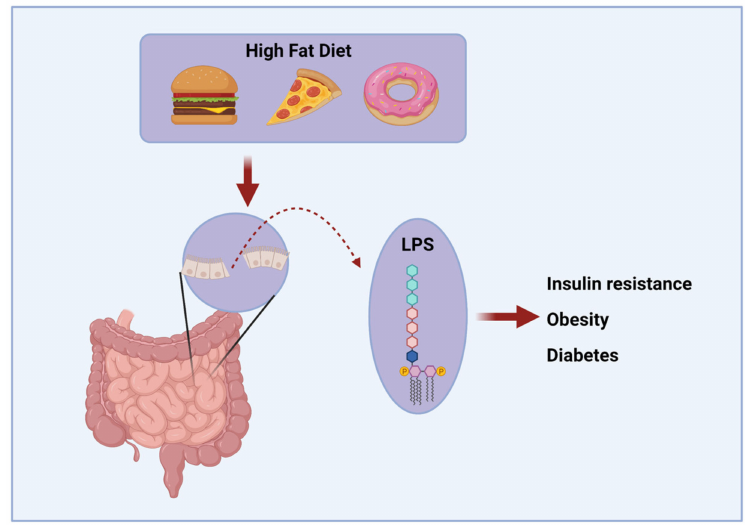
Figure 2. HFD effects on BBB integrity. A diet high in saturated fatty acids can impair BBB integrity and impair